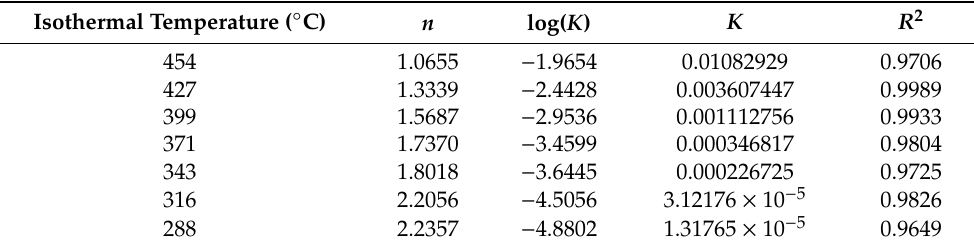
Table 4. Summary of n and K of 4140 steel bainite transformation Avrami constants.